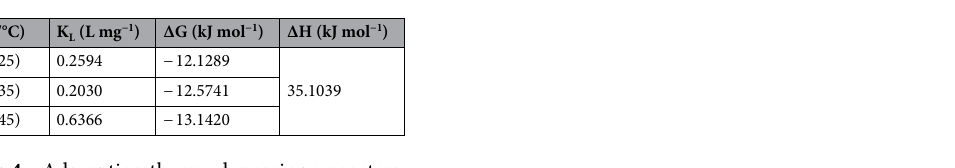
Table 4. Adsorption thermodynamic parameters.